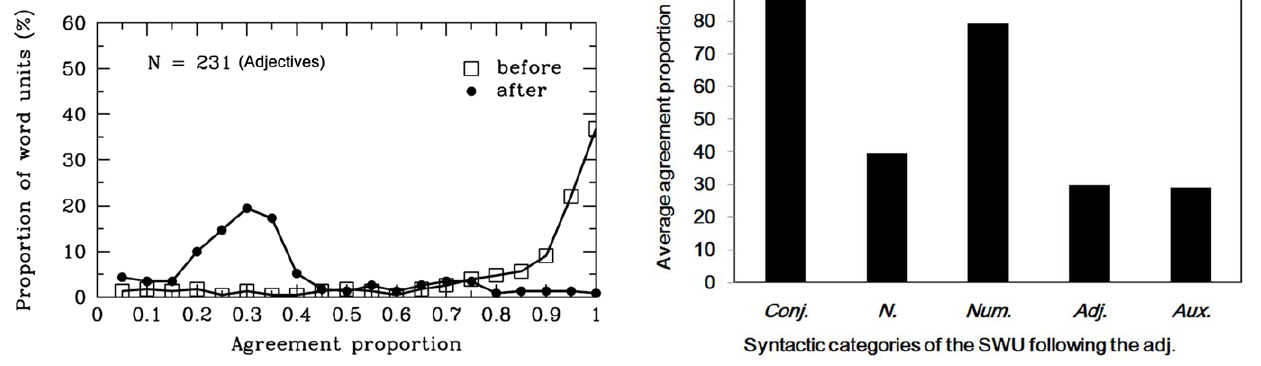
Figure 9. Adjectives and subsequent words. Average agreement proportions for word boundaries between the adjectives and different subsequent syntactic categories of SWU. Conj. = conjunctions; N.=nouns; Num.=numerals; Adj.=adjectives; Aux.=auxiliary words.